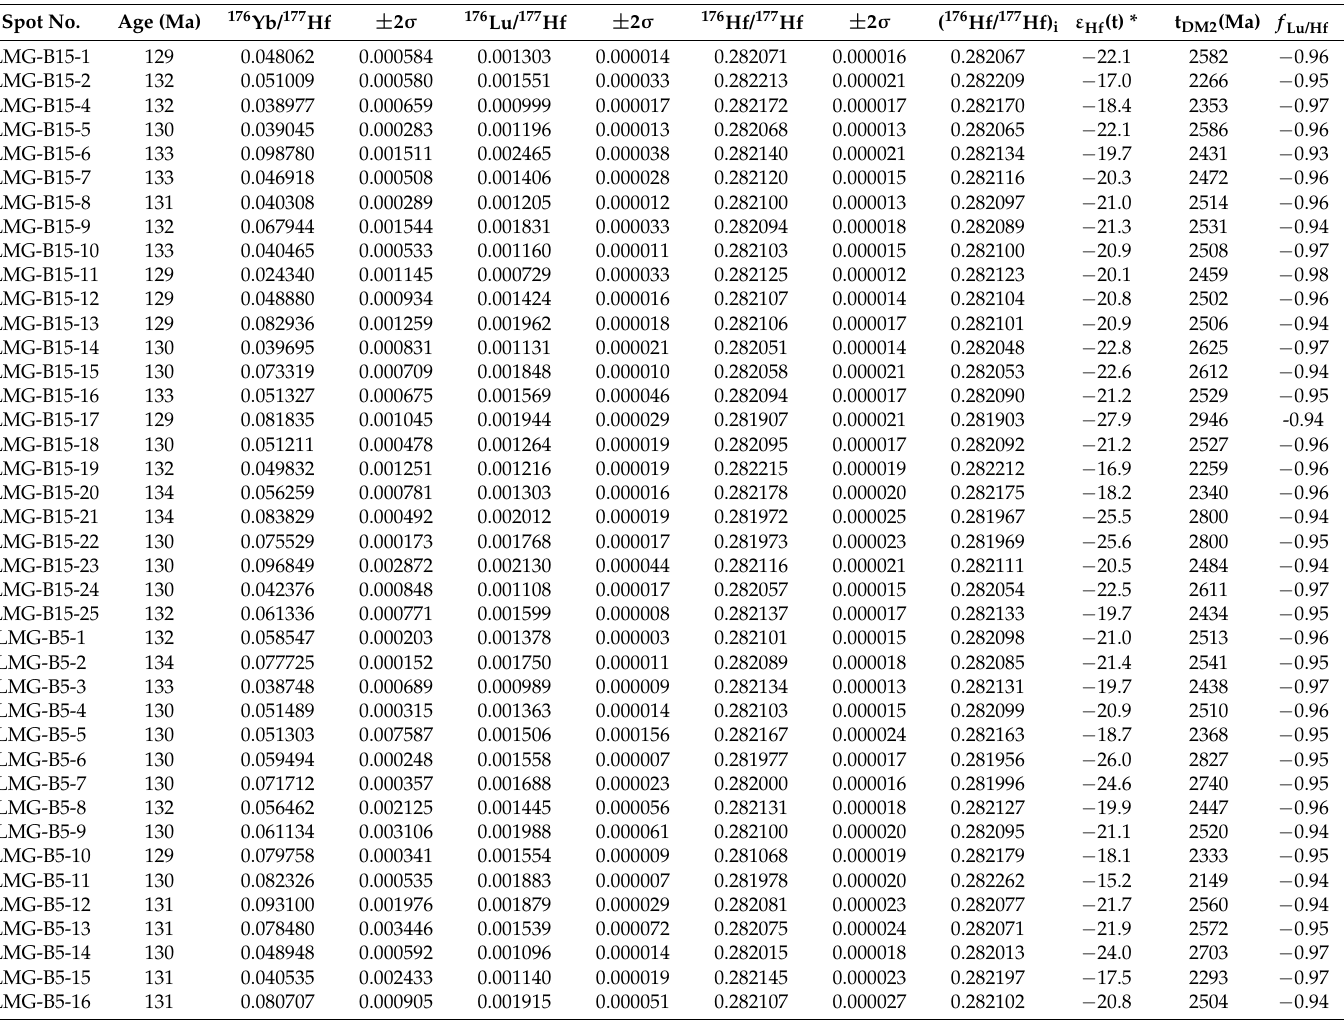
Table 4. Lu–Hf isotopic data of zircons from the Leimengou granite porphyry (LMG-B15) and monzonitic granite porphyry (LMG-B5). Spot